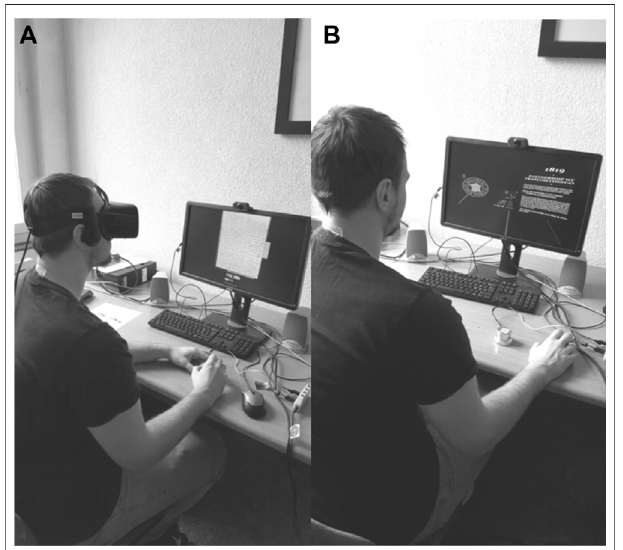
FIGURE 1 | Example participant (actor) in (A) the VR headset condition, (B) the desktop computer condition.